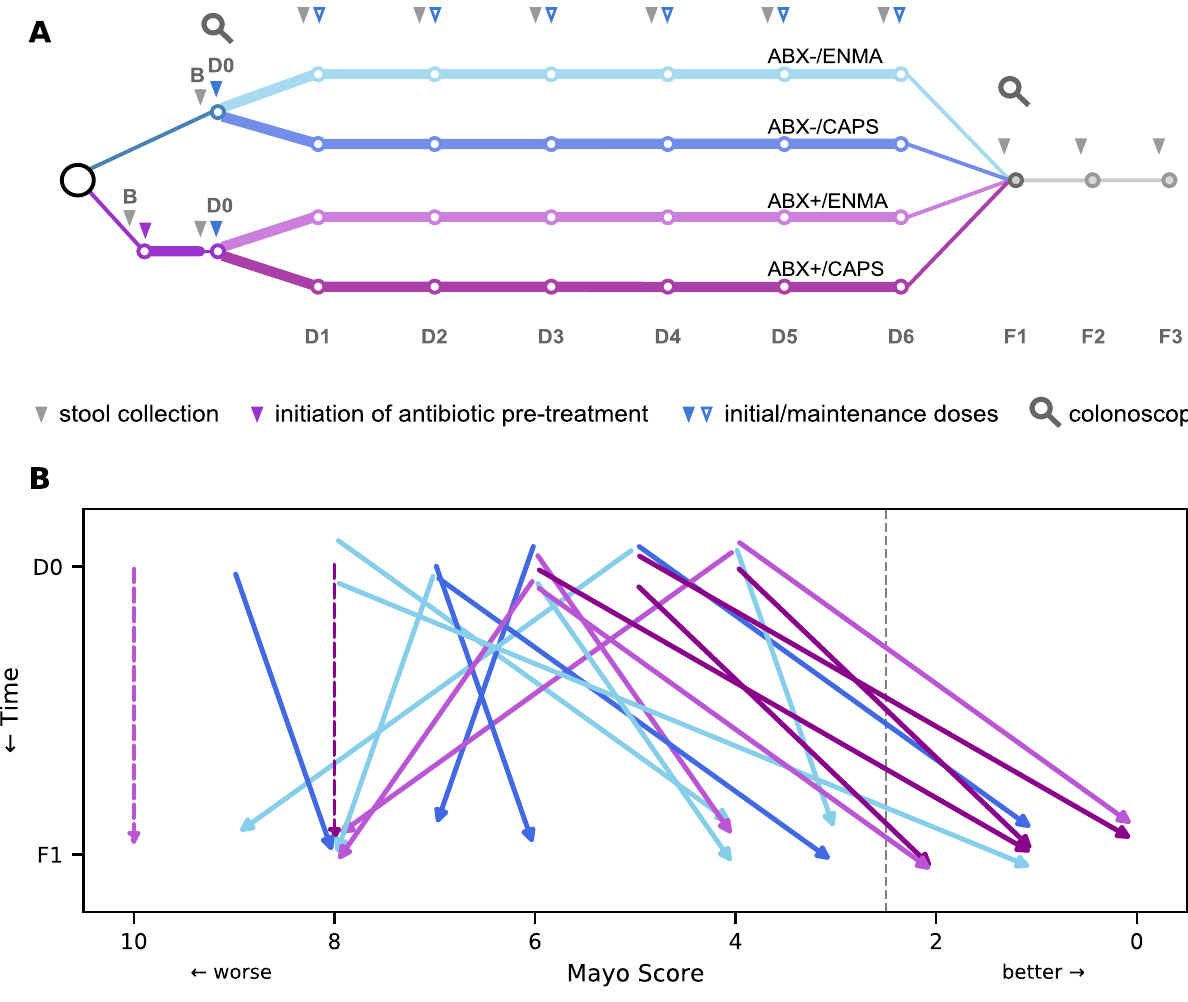
Figure 1. Study design and primary efficacy endpoint of an experimental FMT treatment for UC, showing improved symptoms at follow-up, particularly among patients receiving antibiotics. In our 2 × 2 factorial design, each patient either received antibiotic pretreatment (ABX +) or not (ABX−), and either received capsules (CAPS) or enema (ENMA) for maintenance dosing. (A) Major events during the longitudinal study, including baseline (B) and subsequent fecal sample collections (grey arrowheads), colonoscopies (magnifying glasses), initial FMT (D0, solid blue arrowhead), 6 weekly maintenance doses (D1–D6, open blue arrowheads), and three follow-up appointments (F1–F3). The start of oral antibiotics is represented (purple arrowhead). (B) Change in Mayo scores of each patient between D0 (top) and F1 (bottom). Dashed arrows show the D0 Mayo score of patients who withdrew from the study due to worsening symptoms. Patient arrows are colored by arm and shifted vertically by a small, arbitrary amount to increase visual distinction. The grey dotted line just left of Mayo score 2 marks the remission threshold. All patients with a Mayo score ≤ 2 at F1 also had an endoscopy sub-score that decreased by at least 1 point; therefore, all were considered to be in